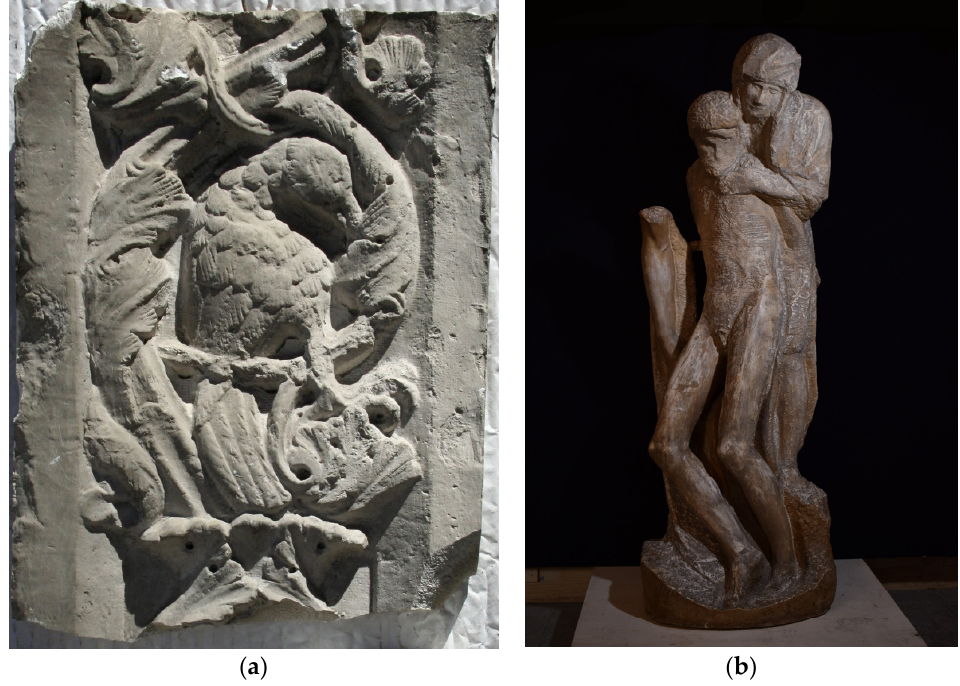
Figure 1. Historical surfaces used for the real case study cleaning analysis ( a ) cast element from the internal porch framing of the Abbey of Nonantola and ( b ) Cast of the Pietà Rondanini.